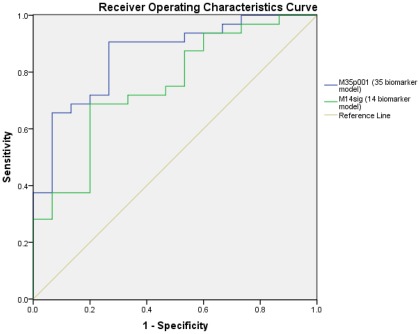
Receiver operating characteristics curve for the 14 and 35 biomarker models.